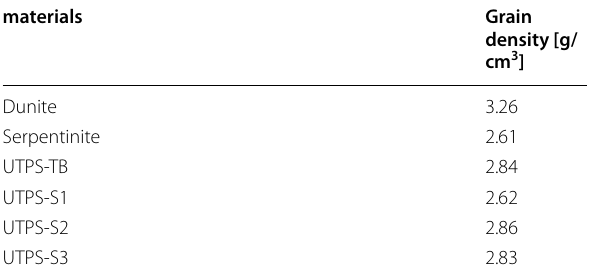
Table 4 Averaged grain density